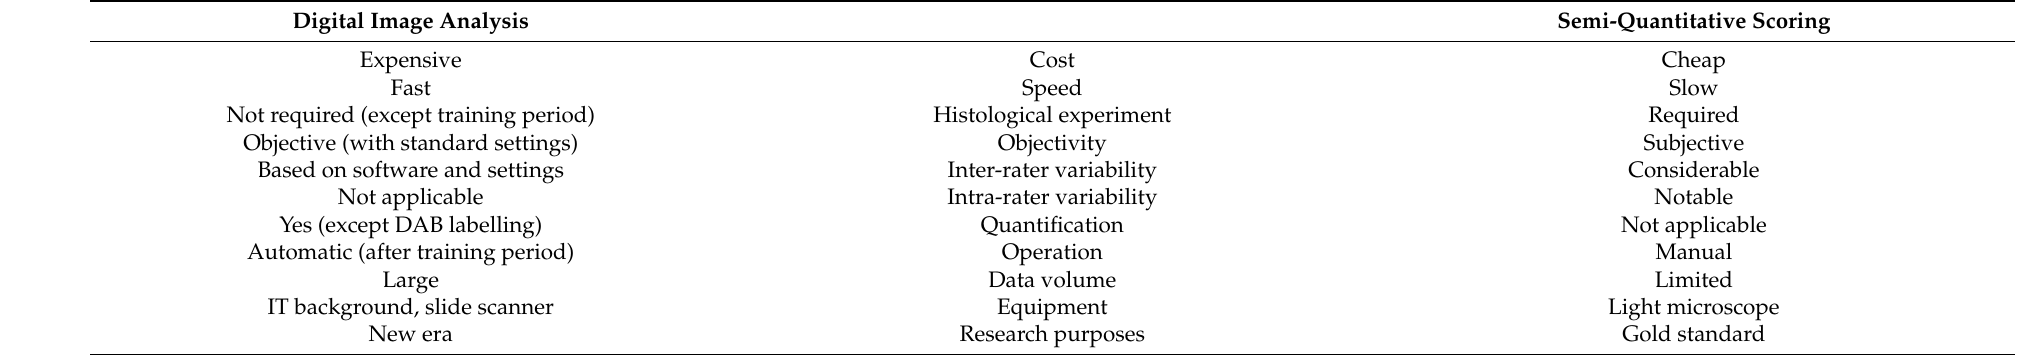
Table 4. Comparison of digital image analysis and semi-quantitative scoring based on relevant factors according to the literature [3,21,22,25,26,33,34,37,39–44]. (DAB = 3,3 (cid:48)